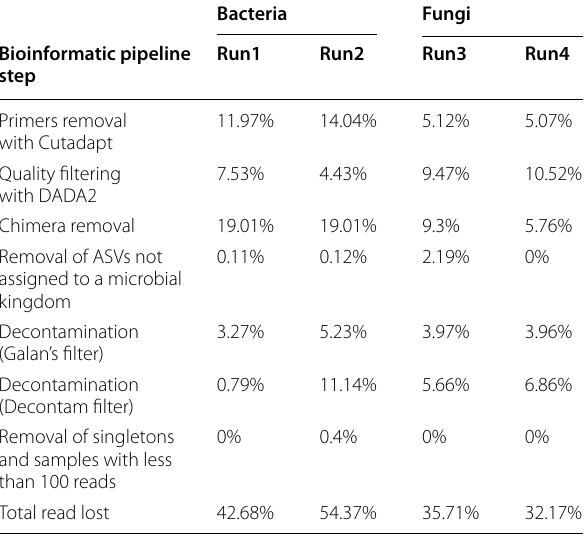
Decontamination (Galan’s